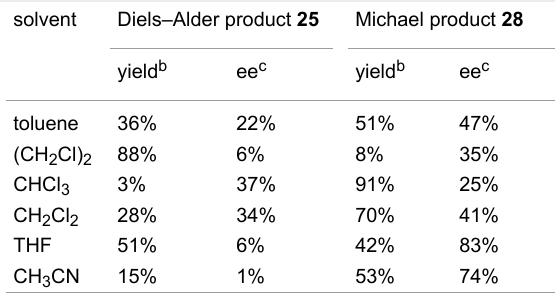
Table 1: Reaction of anthrone 20 and N -phenylmaleimide ( 22 ) in dif- ferent solvents. a